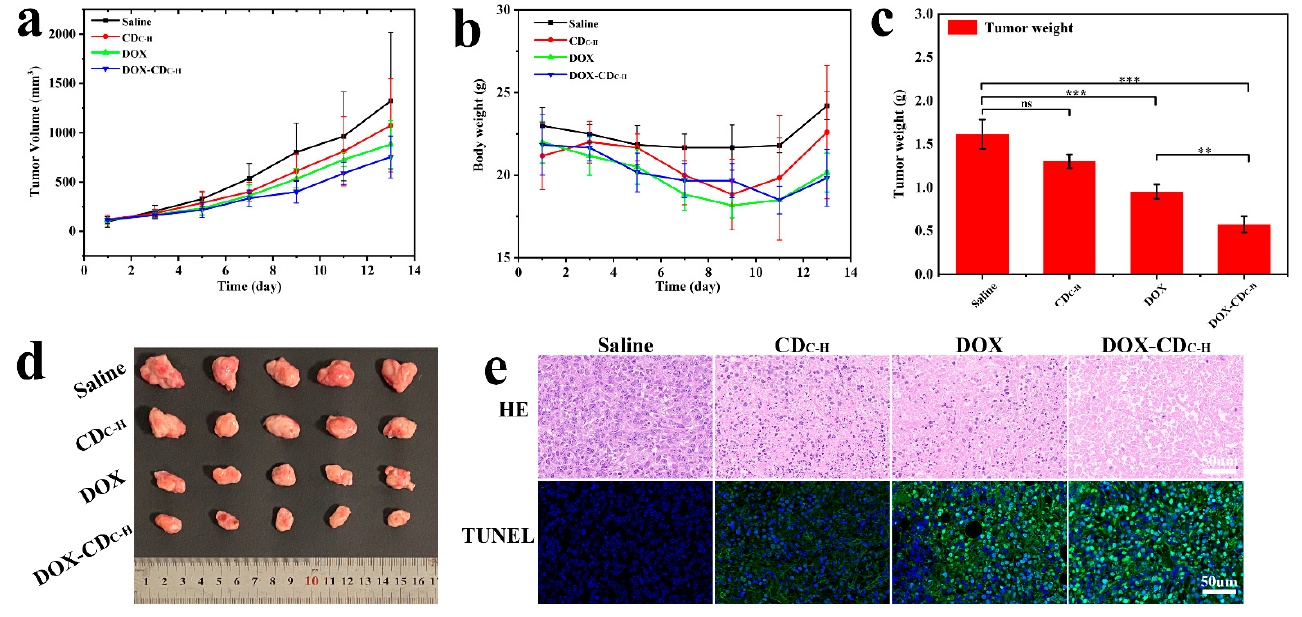
Figure 9. In vivo tumor growth suppression studies. ( a ) Tumor growth curves of mice treated with various formulations and ( b ) body weight changes of mice. ( c ) Tumor weight of different groups after the last treatments (n = 5). ** p <0.01, *** p < 0.001, ns p > 0.05. ( d ) Images of tumors from each group. ( e ) H&E and TUNEL analyses of excised tumors after the last treatments. Scale bars: 50 µm.